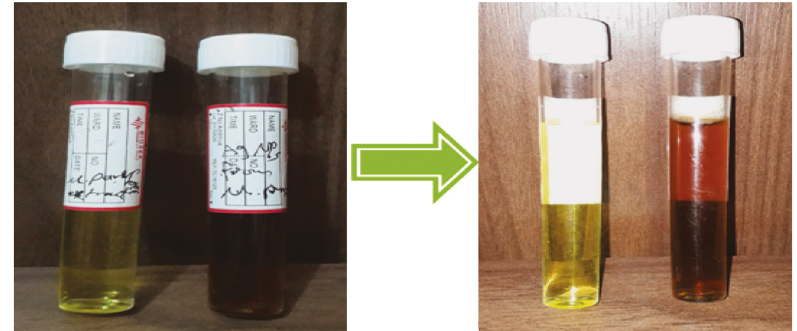
Figure 4: Color change during the reduction process for biosynthesis of AgNPs.